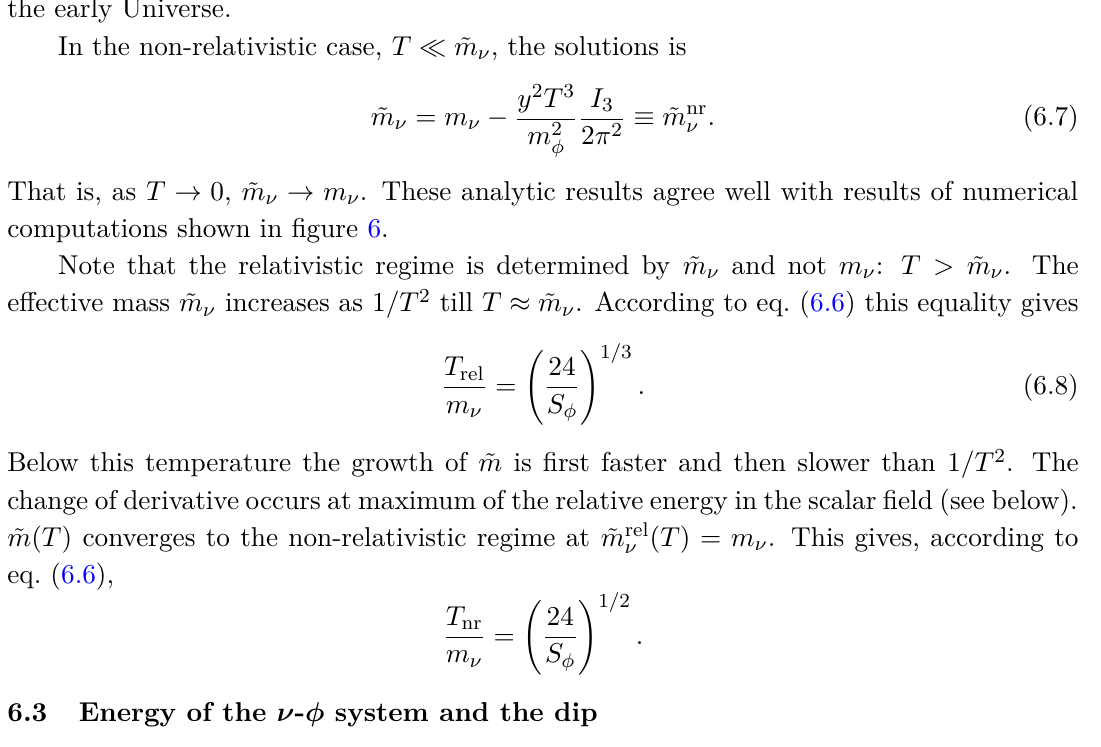
∝ T − 2 decreases as T increases and becomes negligible in ν